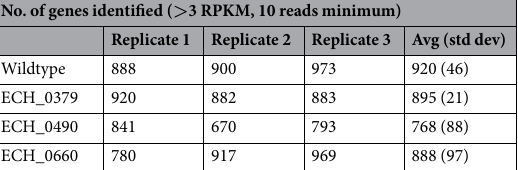
Table 1. Number of E . chaffeensis genes identified in three replicates of wildtype and its